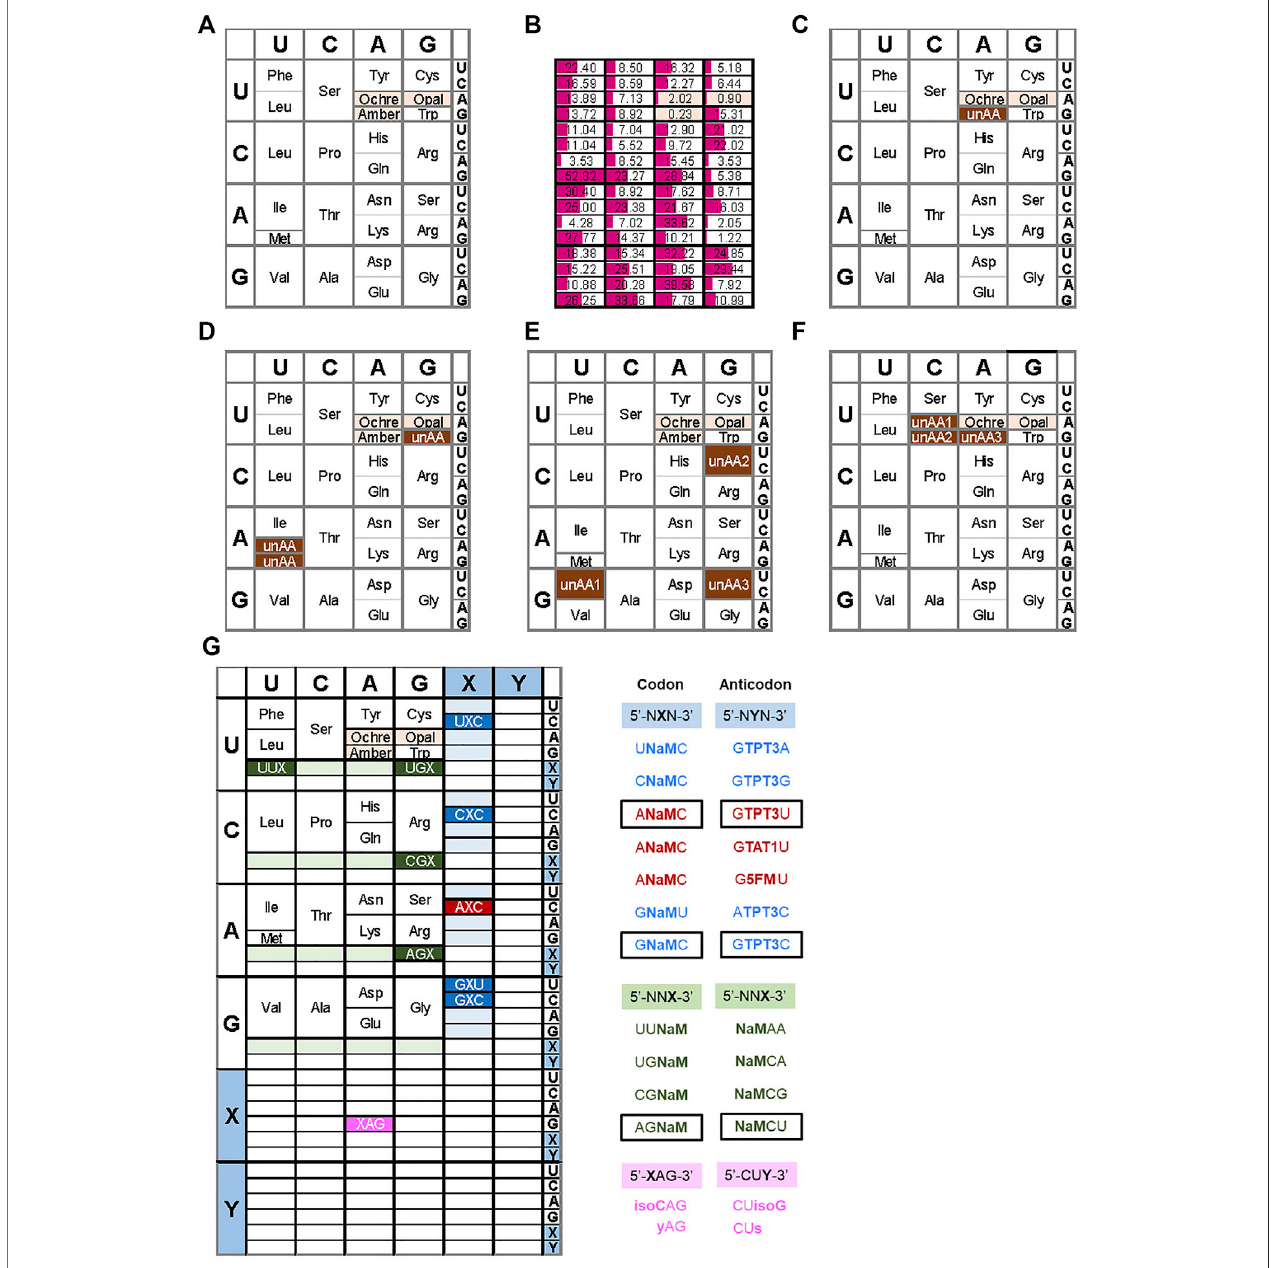
FIGURE1| Examplesofexpandedgeneticcodontables (A) Theoriginalgeneticcodontable (B) Relativefrequenciesofcodonusagein E.coli (C) Reassignmentof theambercodontoanunnaturalaminoacid(unAA) (D) UseofsensecodonsforunAA,suchasTrpcodon(UGG)foranunAA(i.e.,4- fl uorotryptophan) (E) Exampleofthe reprogrammed genetic codon table by Suga ’ s RAPID method (F) Reprogrammed genetic codon table in the engineered E. coli (Syn61) (G) Expanded genetic codon table using UBPs. Examples of the reported UB codon-anticodons are shown on the right.